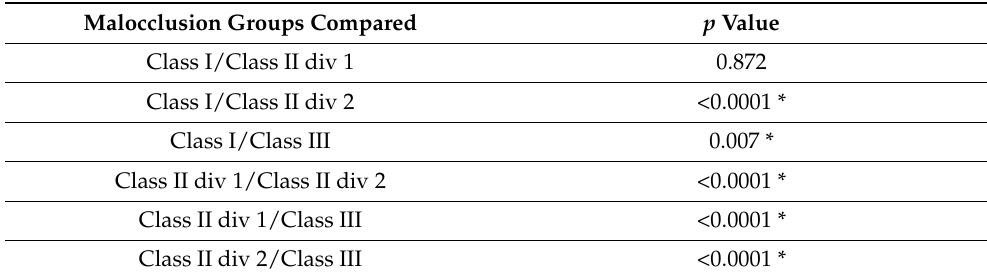
Table 4. Post hoc pairwise comparisons using Boneferroni